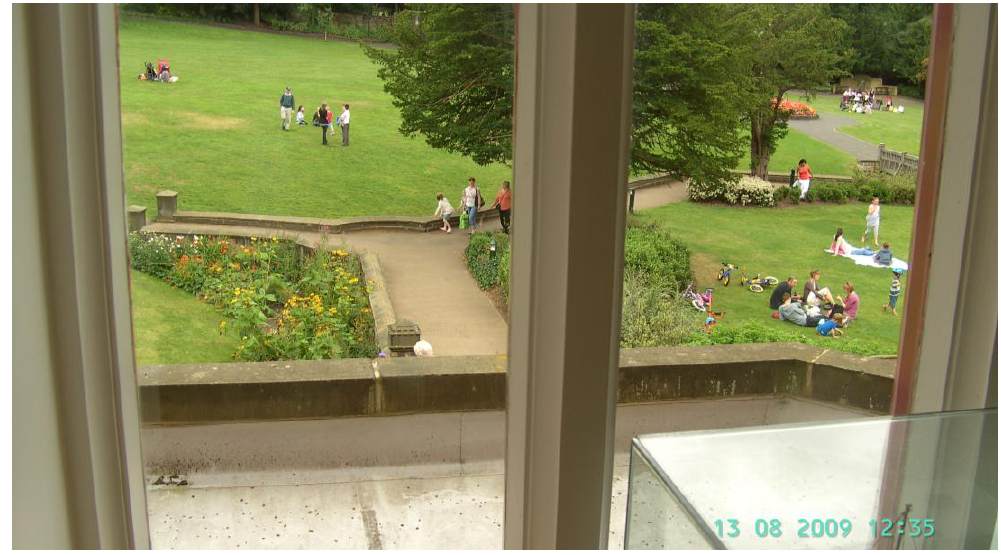
Figure 8. Looking south from the Towers.